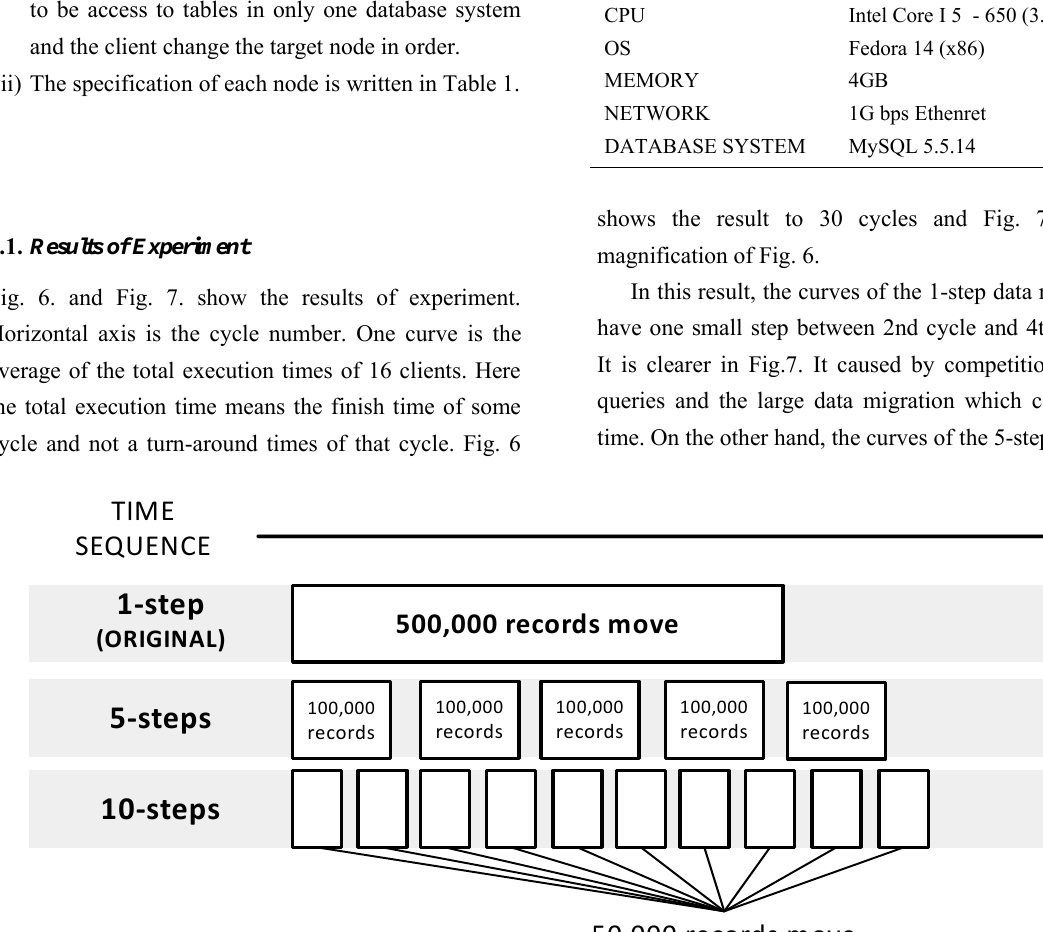
Fig. 5. the incremental data migration in this